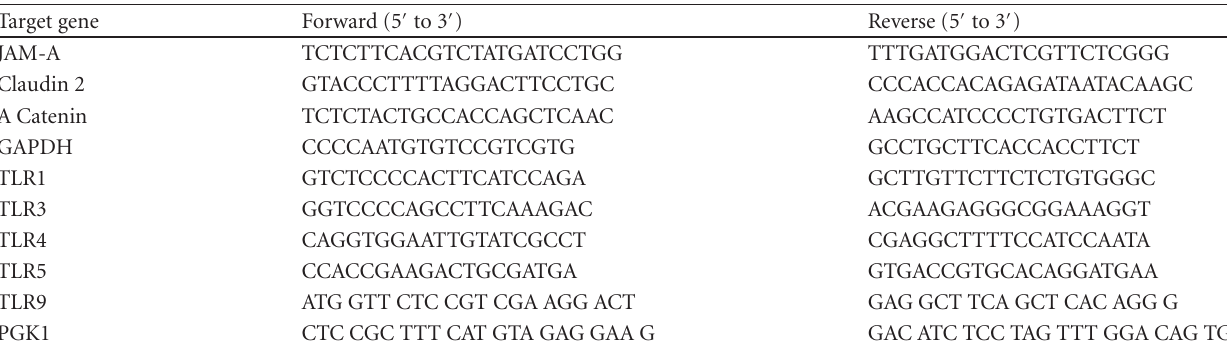
Target gene Forward (5 (cid:2) to 3 (cid:2) ) Reverse (5 (cid:2) to 3 (cid:2) )